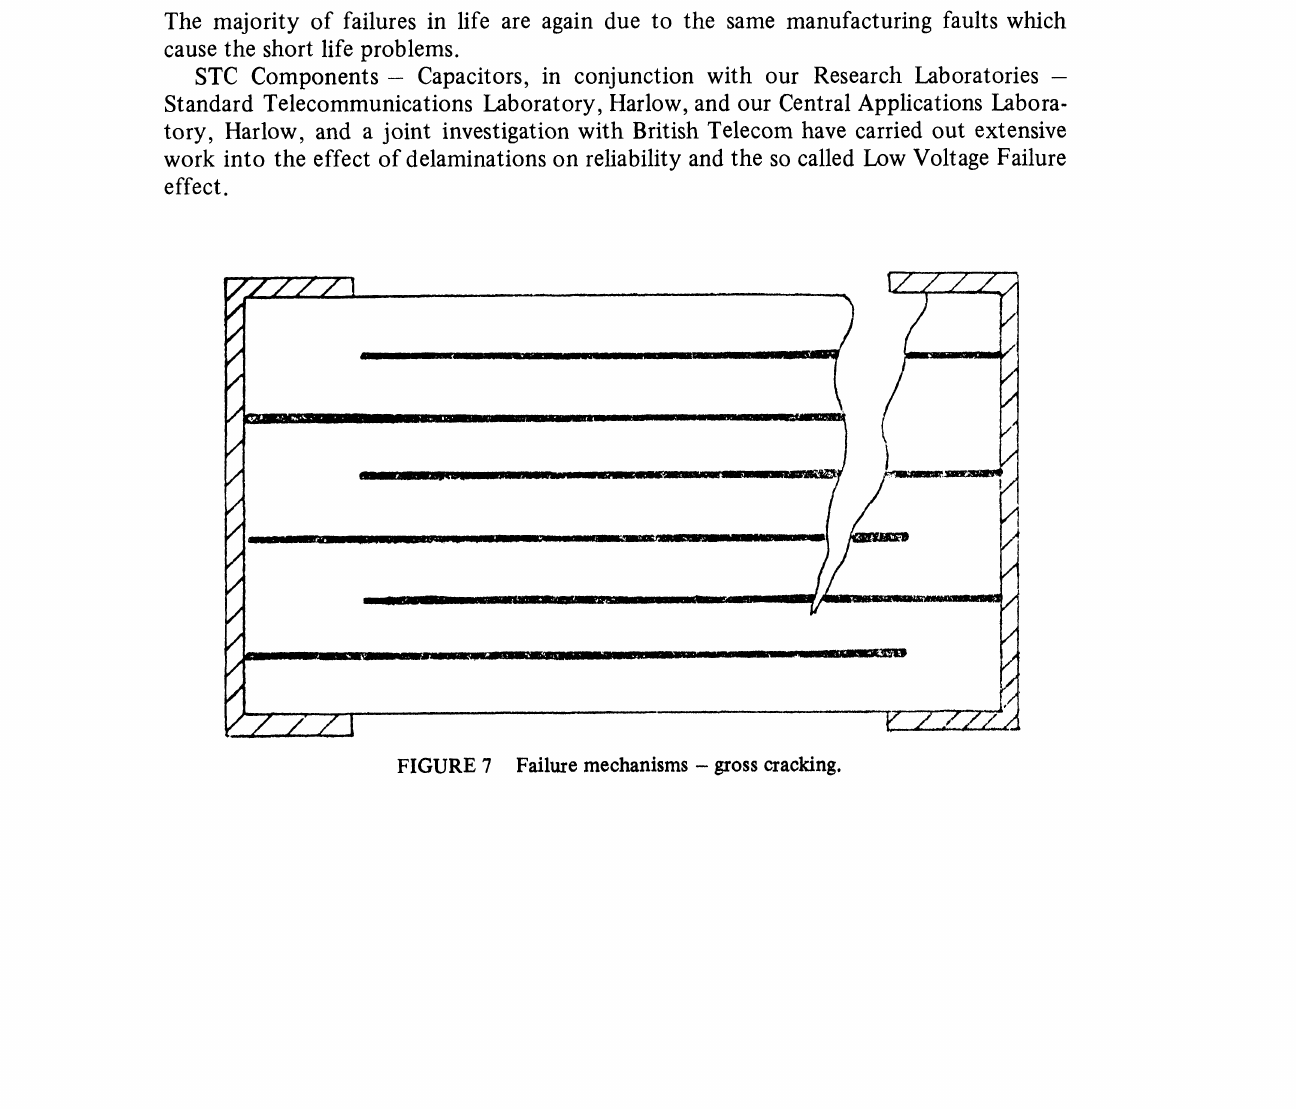
Failure mechanisms gross